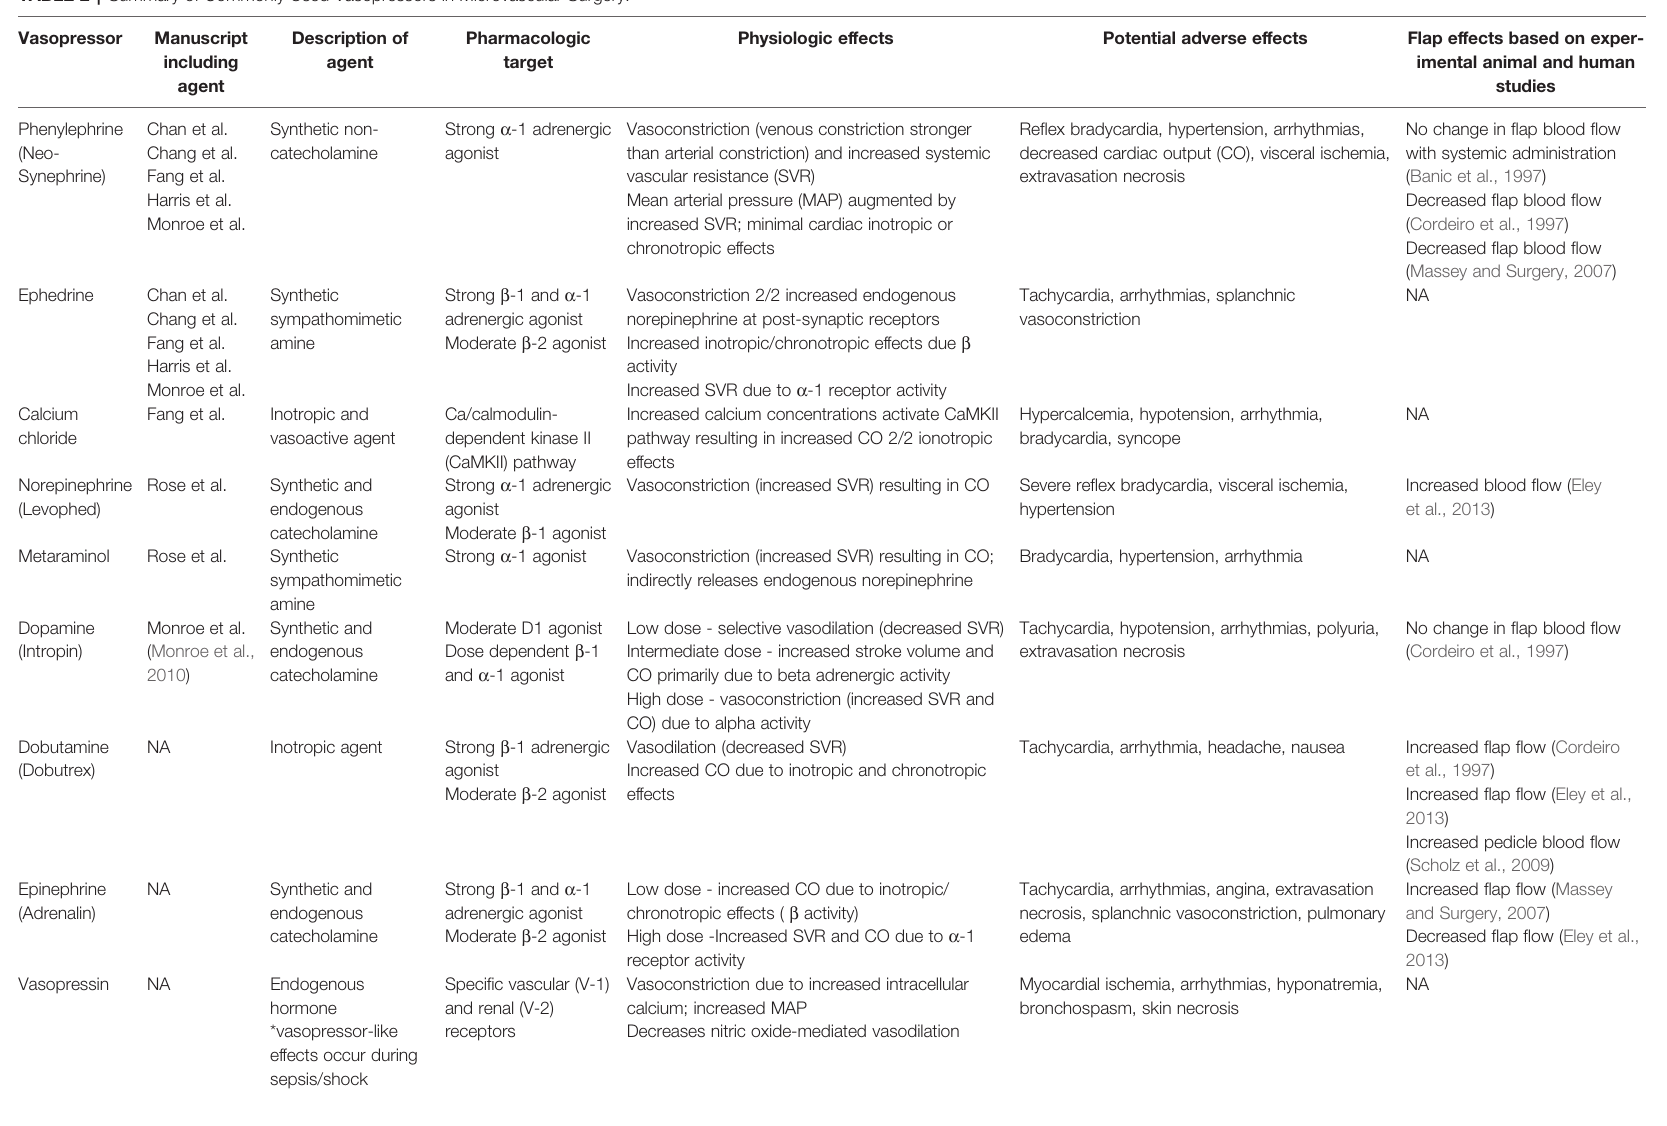
TABLE 2 | Summary of Commonly Used Vasopressors in Microvascular